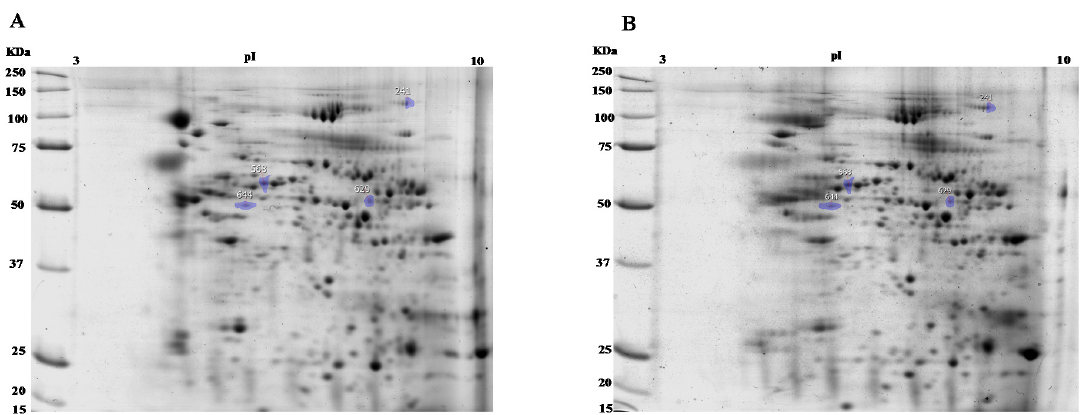
Figure 1. Representative 2-D electrophoresis map of boar spermatozoa extracts. ( A ) Fresh boar spermatozoa extracts, ( B ) liquid stored boar spermatozoa extracts. Differentially expressed proteins are indicated in the map. KDa: protein molecular weight expressed in kilodalton; pI: isoelectric point.